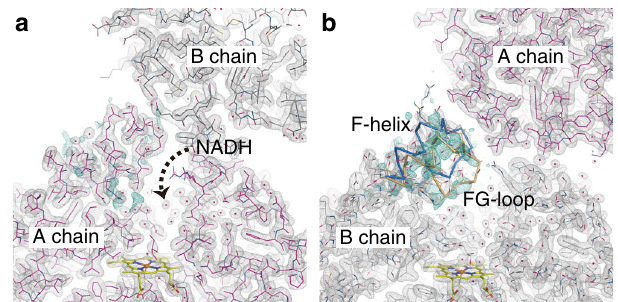
Fig. 5 Structure of the NADH channel entrance in the a A and b B chains of resting P450nor at ambient temperature. The 2 F o − F c maps are shown in gray and contoured at 1.0 σ . The F o − F c positive maps are shown in turquoise and contoured at 2.3 σ . The structure factor F c was calculated from the open form (blue C α trace) of the NADH channel. The re fi ned structure of the closed form is shown in orange (40% occupancy). The structures using the “ Dark2 ” data of MC-2 are